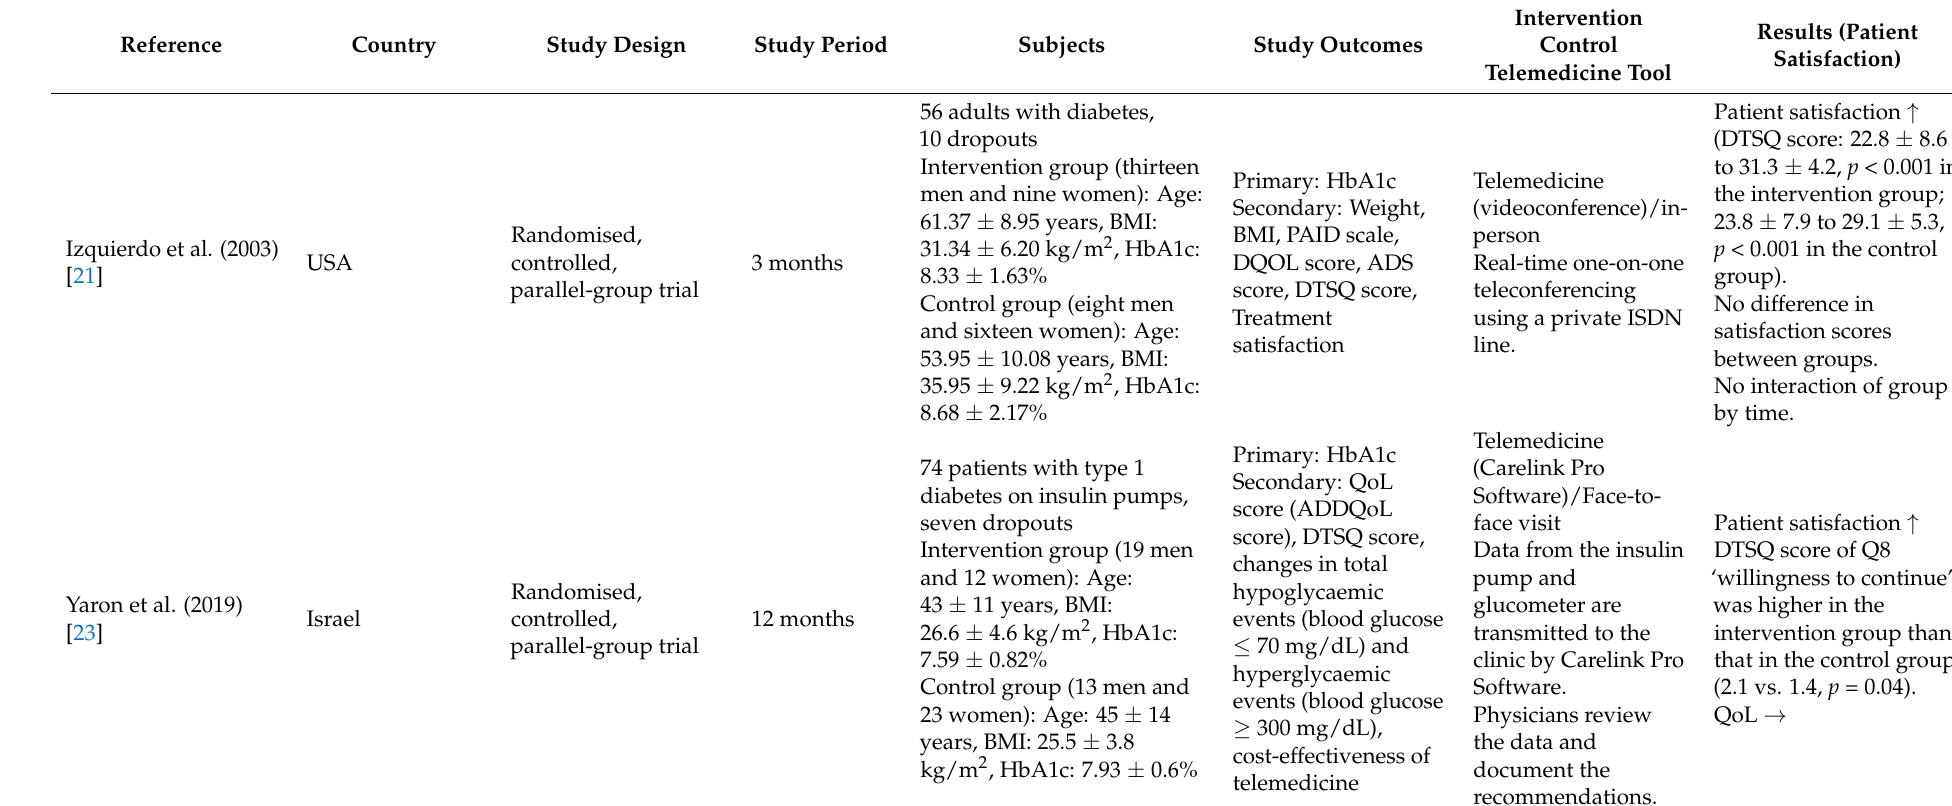
Table 1. Summary of included